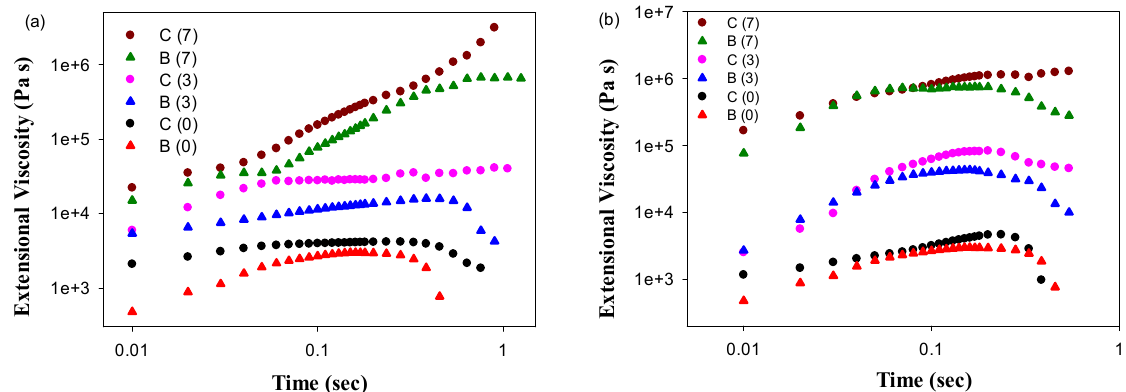
Figure 2. Time-dependence of tensile stress growth coefficient η + (t, ) for molten PLA/PBAT as well as PLA/PBAT/CNFs blends and in situ generated composites. The shear tests were performed at temperatures 70 °C ( a ) and 120 °C ( b ). Curves were shifted vertically for better visualization. C and B stand for the composite and blend, respectively. The numbers in parentheses indicate the concentration of CNFs.